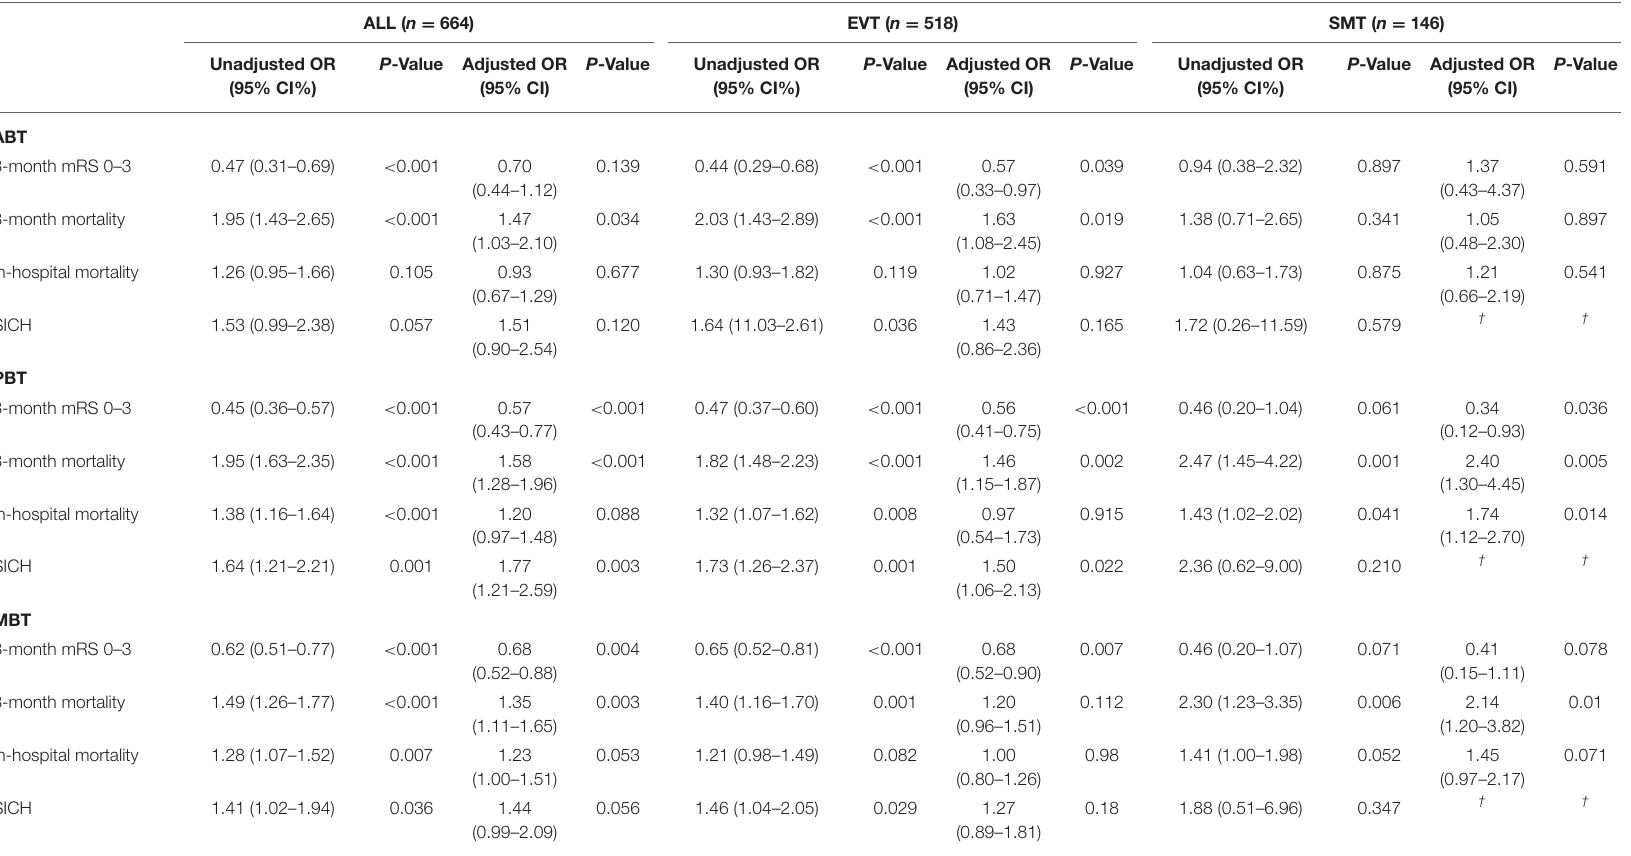
TABLE 2 | Multivariate analysis: association between body temperature and outcomes. ALL ( n =